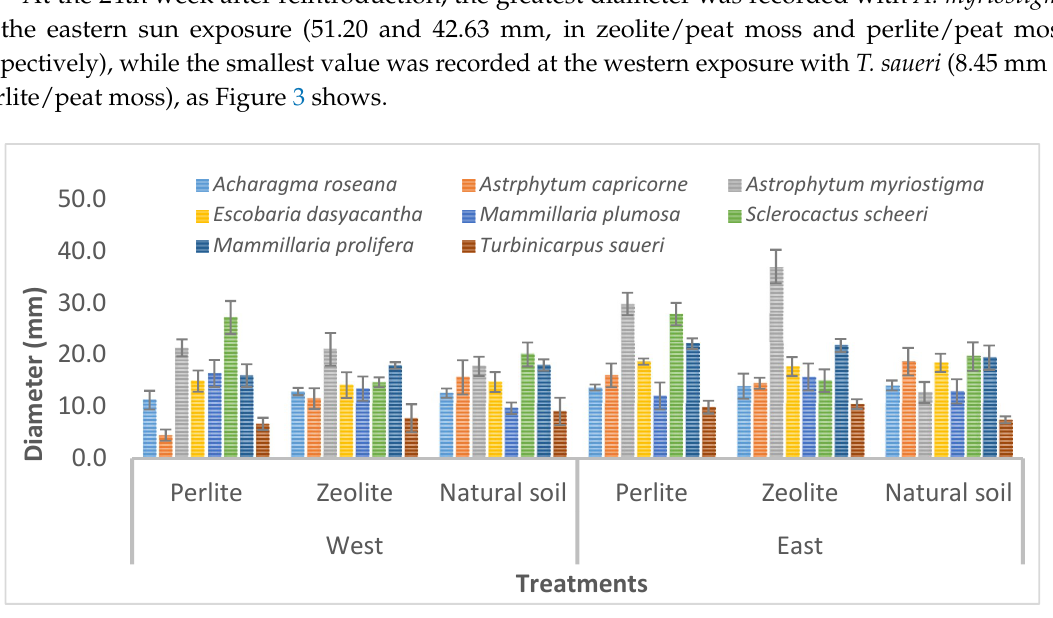
Figure 3. Diameter of eight cacti species, at 24 weeks in different treatments.